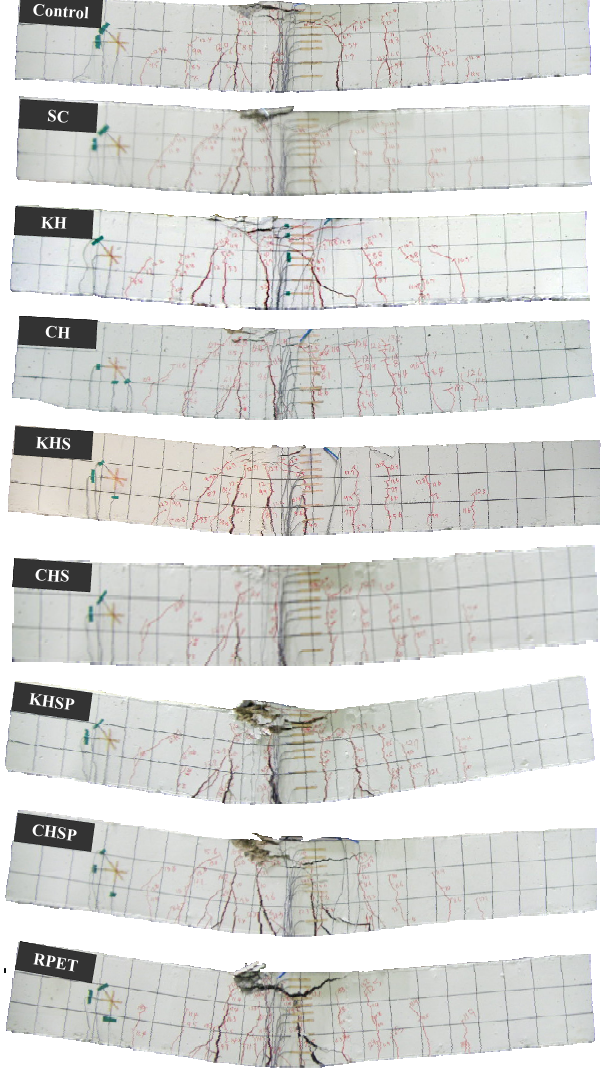
Figure 16. Failure mode and crack patterns of various RC